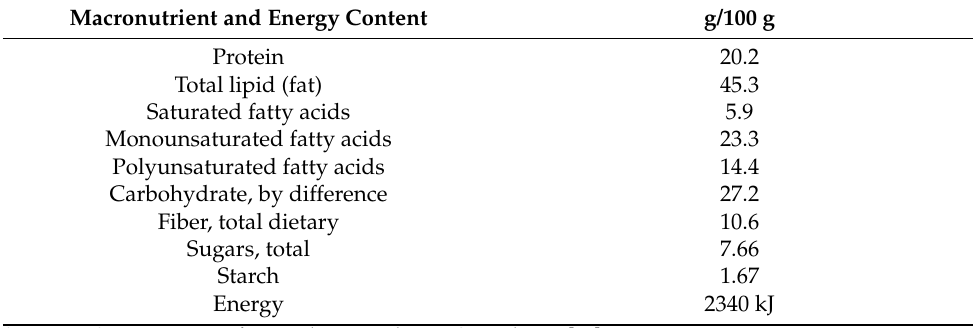
Table 1. Pistachio (raw, unsalted) composition.